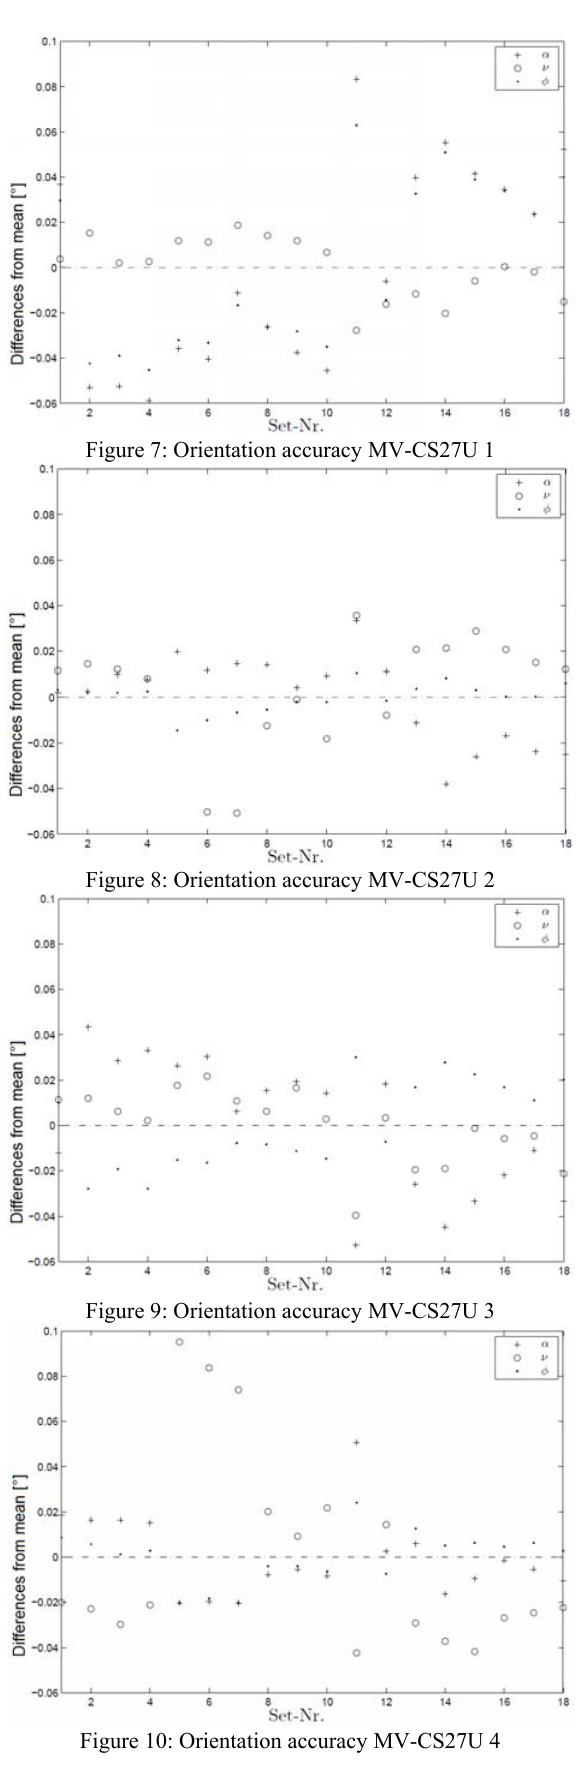
Figure 10: Orientation accuracy MV-CS27U 4